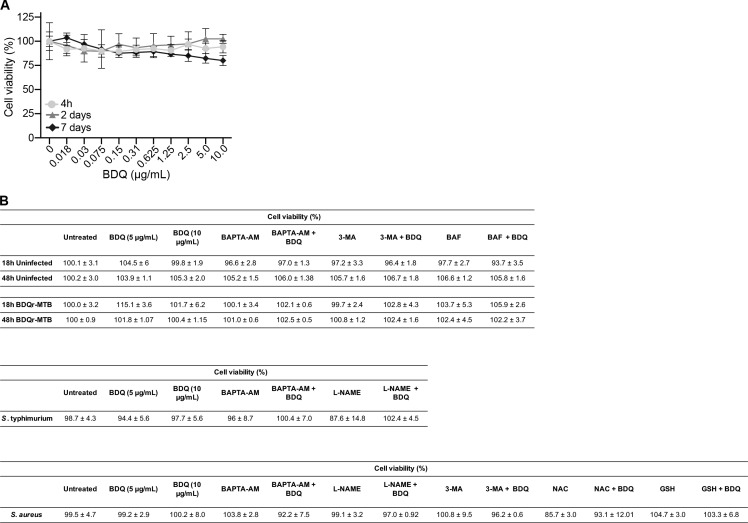
Cell viability assay of macrophages incubated with BDQ.(A) Cells were treated with various concentrations of BDQ. After 4 hr, 2 and 7 days, cell viability was evaluated with the MTT assay (Trevigen) according to the manufacturer's instructions. (B) Uninfected and cells infected with BDQr-MTB, S. Typhimurium and S. aureus were treated with BDQ with/without the inhibitors used in this study. Cell viability was evaluated with the LDH assay according to the manufacturer’s instructions. Results represent the mean ± SD of three replicates. One representative experiment (out of three) is shown.